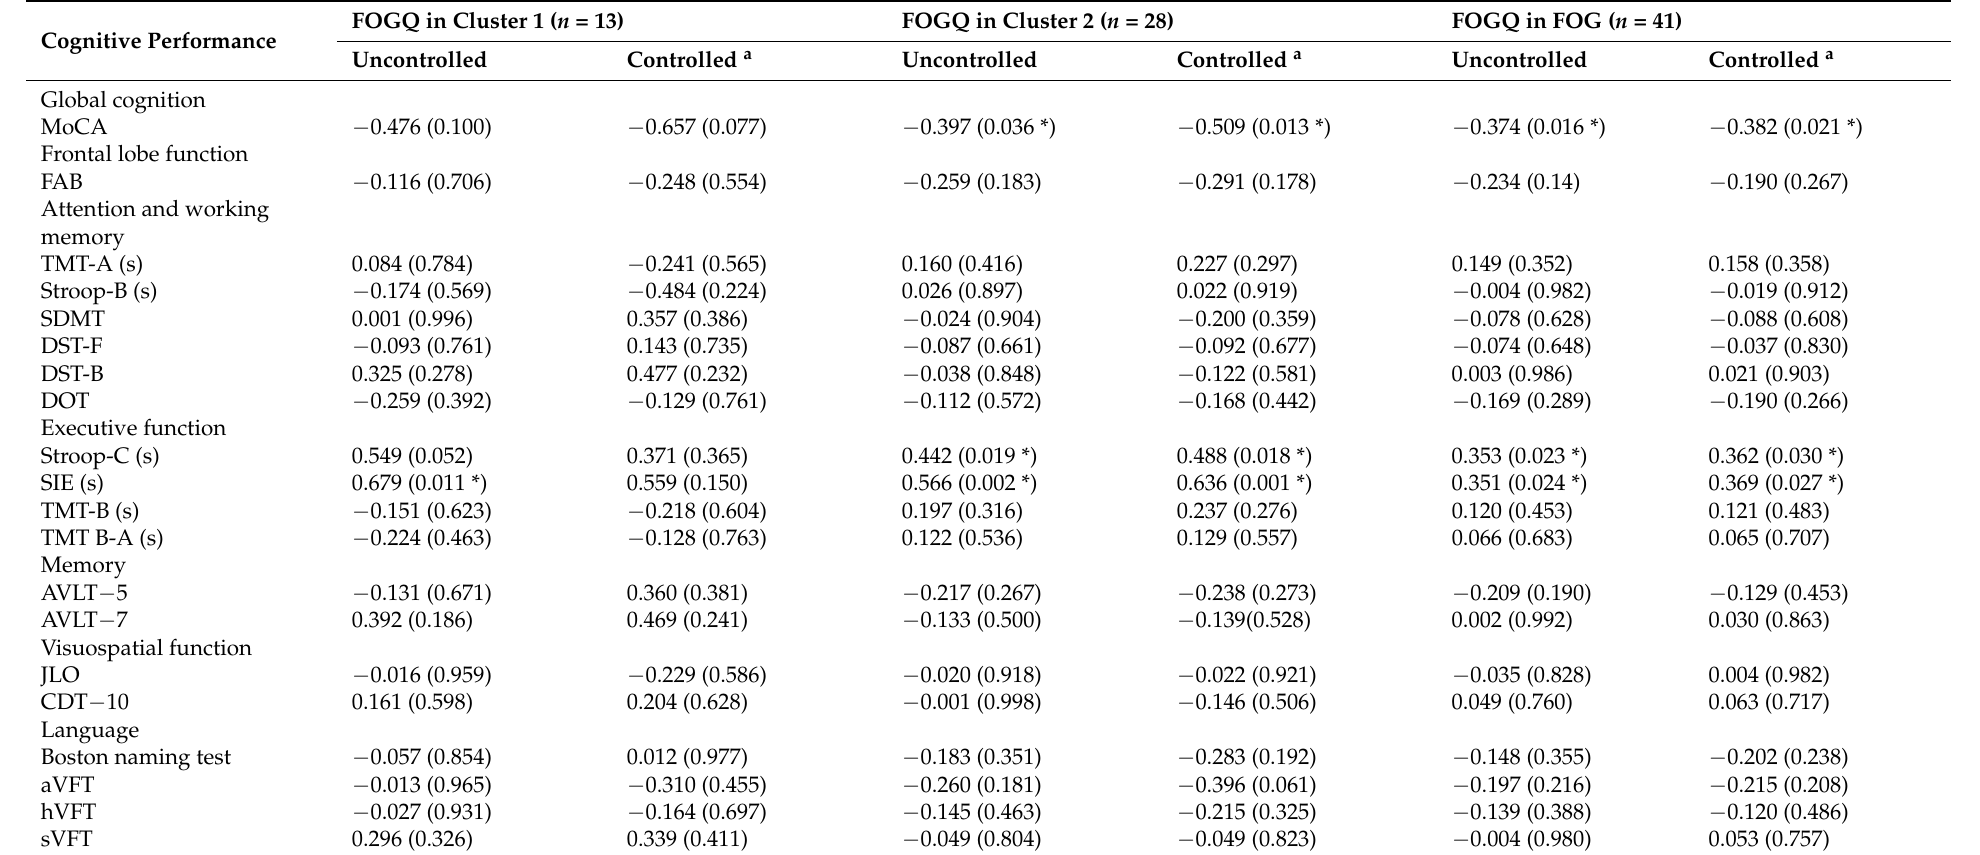
Table 4. Correlation analysis between FOG severity and cognitive performance in patients with